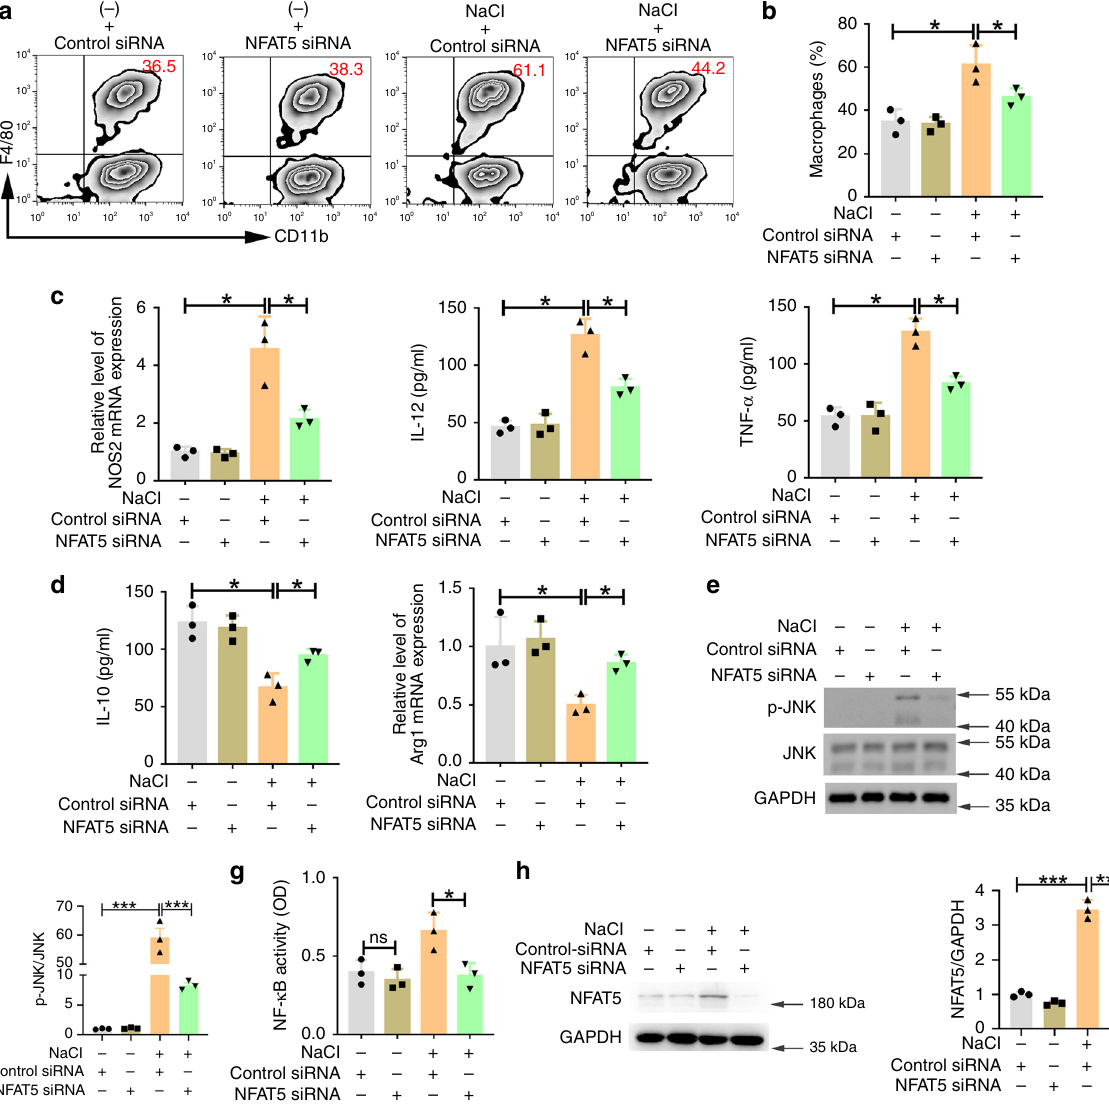
Fig. 8 NFAT5 silencing inhibited high-salt-mediated M-MDSC differentiation and functional transformation. a , b Puri fi ed tumour M-MDSCs were transfected with NFAT5-speci fi c siRNA and cultured in the absence or presence of an additional 40 mM NaCl for 3 days. Populations of CD11b + F4/80 + cells were tested by fl ow cytometry. c , d Puri fi ed tumour M-MDSCs were transfected with NFAT5-speci fi c siRNA for 2 days and cultured in the absence or presence of an additional 40 mM NaCl for 24 h. The expression of IL-12, TNF- α and IL-10 in the supernatant was determined by ELISA. NOS2 and Arg1 mRNA expression levels were evaluated by qRT-PCR. e – g p-JNK was analysed by western blotting; quanti fi cation data of western blotting and NF- κ B activity were determined by the p65 subunit DNA-binding ability. h NFAT5 expression was analysed by western blotting. Right panels: quanti fi cation data. For all panels, * p < 0.05 and *** p < 0.001. Bars are expressed as the means ± SEM of three independent replicates with isolated pooled cells. These experiments were repeated three times and were replicated with similar results; n = 5 mice; one-way ANOVA with post hoc Bonferroni correction. Source data are provided as a Source Data fi